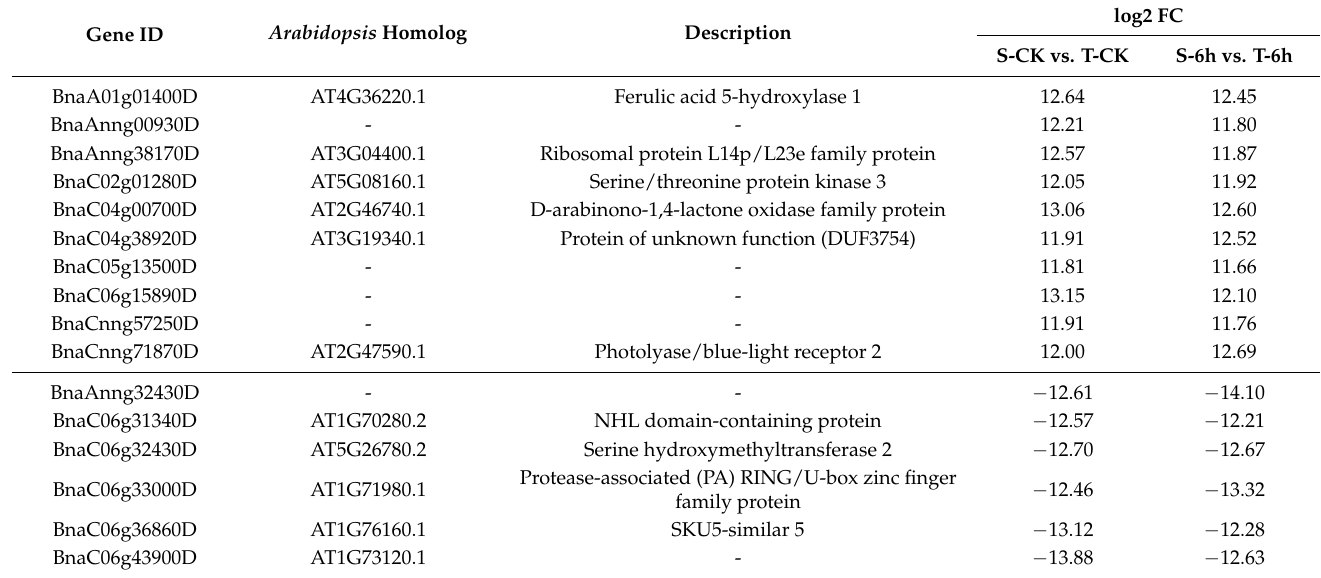
Table 2. Synchronously up-/ down-regulated genes within top 20 DEGs between treatments. Gene